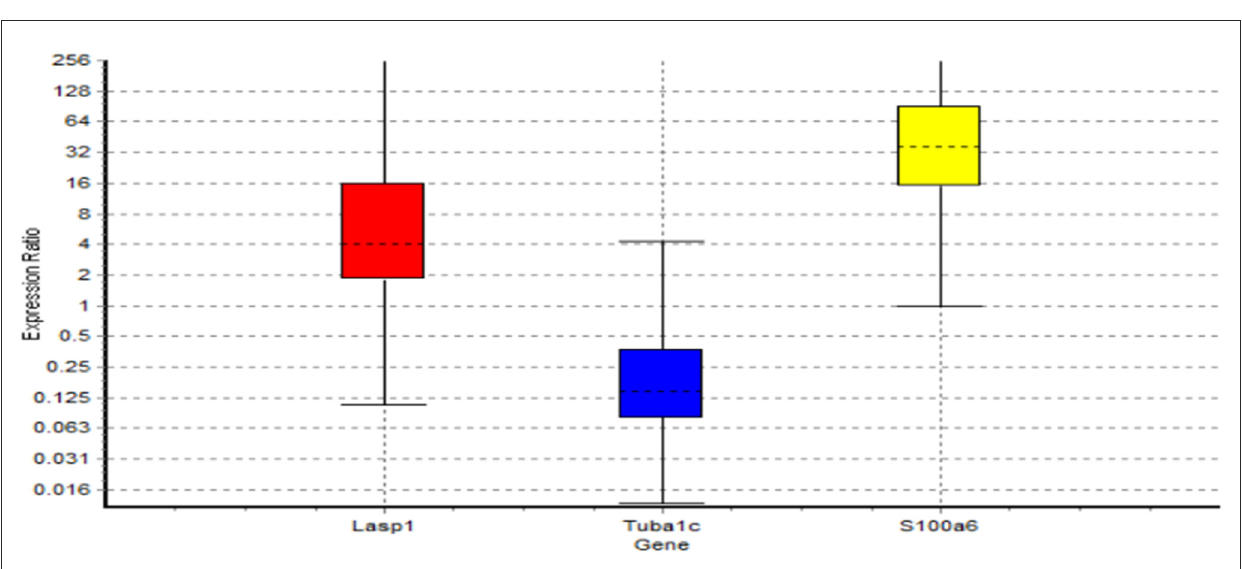
process. S100A6 functions in a wide range of cell types as a member of the S100 family and this family expression in MS patients could be considered as a diagnostic biomarker for